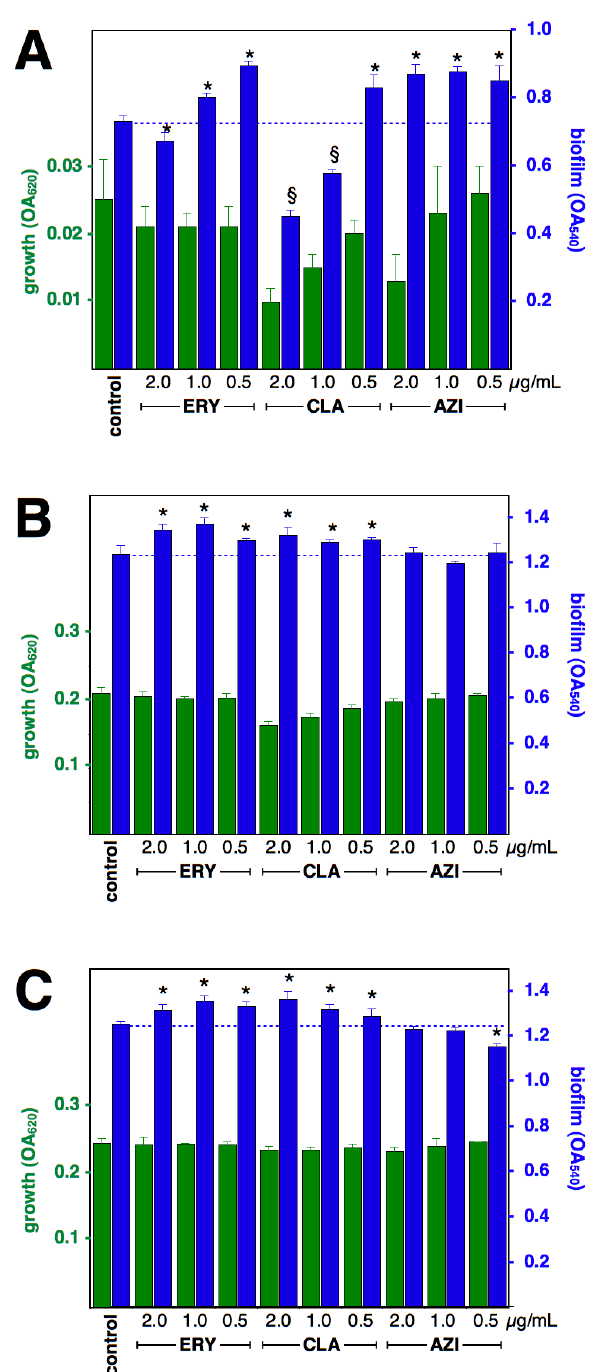
Figure 1. Effect of macrolides upon biofilm formation by S. aureus strain RN11 (constitutive MLS B ). Growth (green) and biofilm formation (blue), at 4 h ( A ), 8 h ( B ) and 12 h ( C ), shown as OA at 620 and 540 nm, respectively (means and standard deviations of four independent experiments). * p < 0.05 by Student t -test against control. Growth was significantly ( p < 0.05) reduced by AZI 2 µg/mL/4h and CLA 1 and 2 µg/mL/8 h, yet biofilm formation was significantly larger than control. § not statistically evaluated, due to diminished growth.